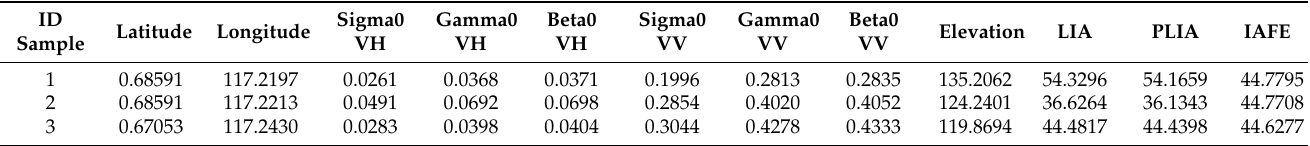
Table 5. Example of backscatter data extracted from Sentinel 1A images.